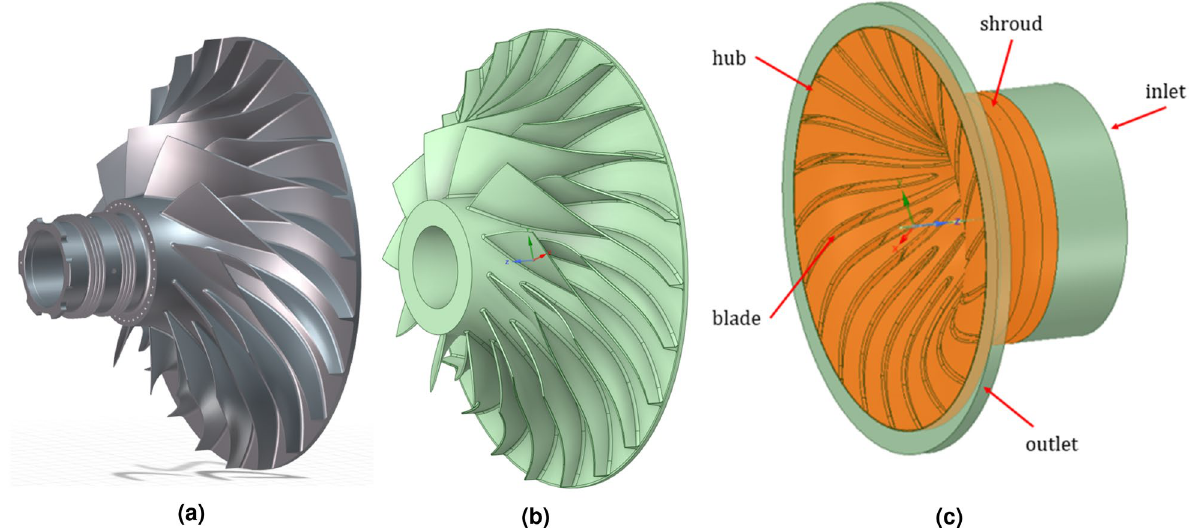
Figure 2. View of centrifugal compressor of DGEN 380: ( a ) geometrical model from the virtual dynamometer 30 , ( b ) simplified geometrical model for FEM analysis (Ansys Mechanical 34 and ( c ) fluid domain (Ansys CFX 35 Fig. 2b. This compressor spins at 51,410 RPM under cruise conditions. According to the engine documentation, about 1.78 kg/s flows through the inner passage, i.e. about 0.162 kg/s through one inter-vane zone of the rotor of the centrifugal compressor.